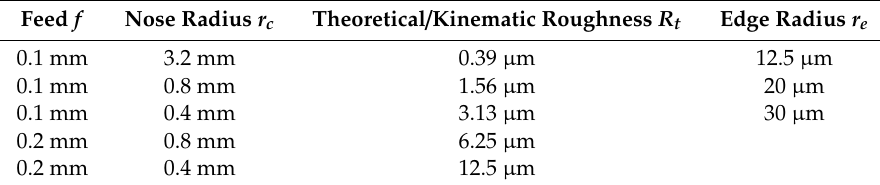
Table 1. Experimental parameters.